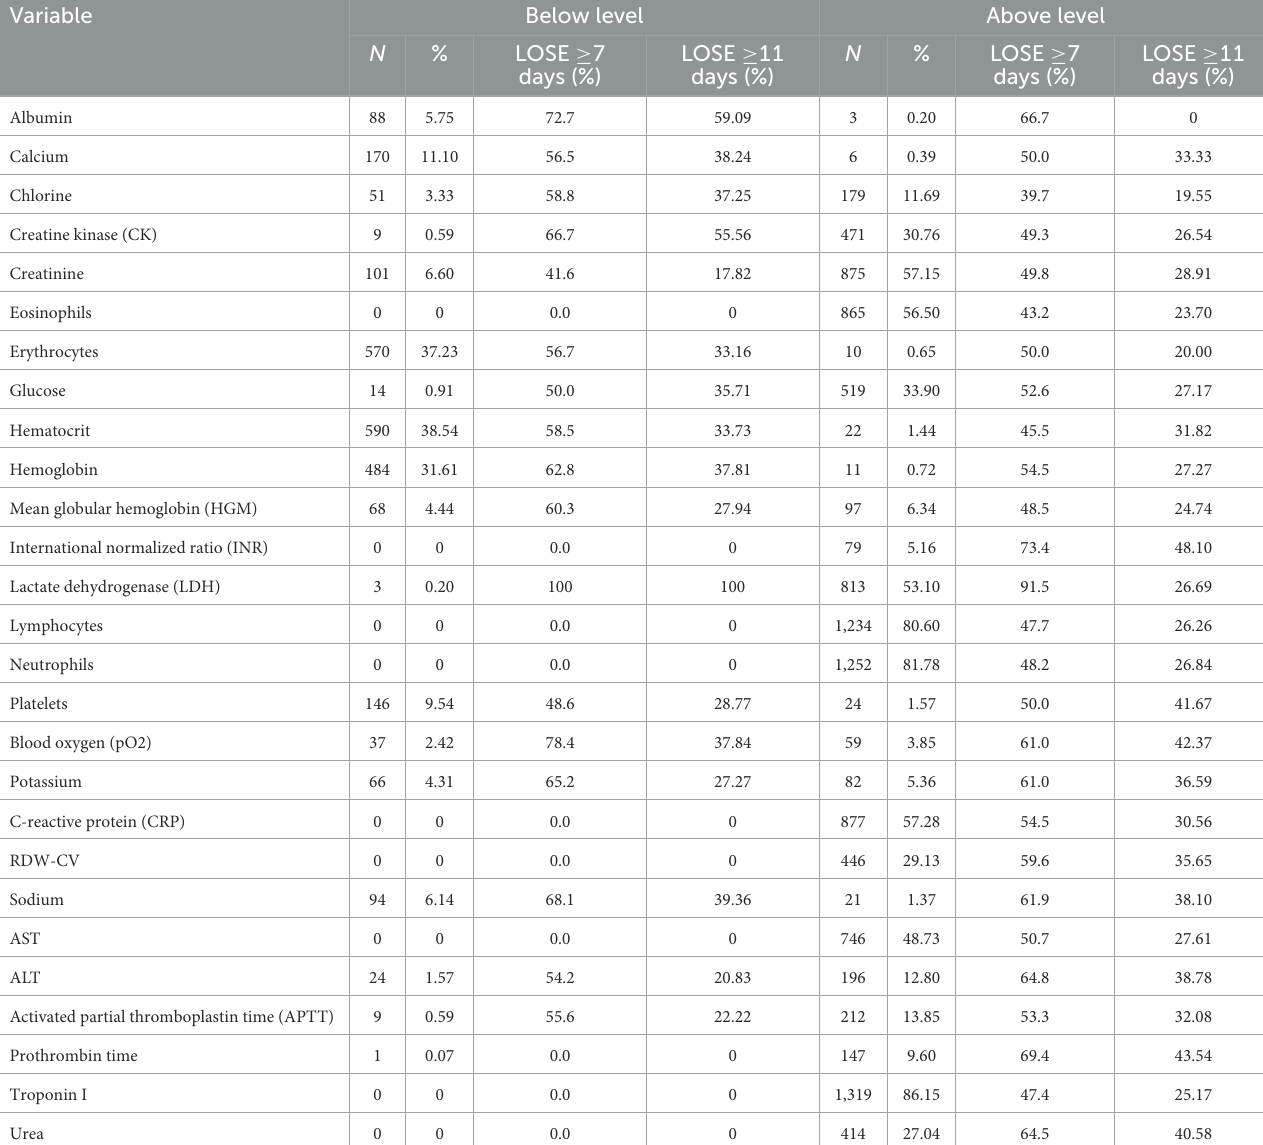
TABLE 2 Descriptive statistics of the study population—Laboratory